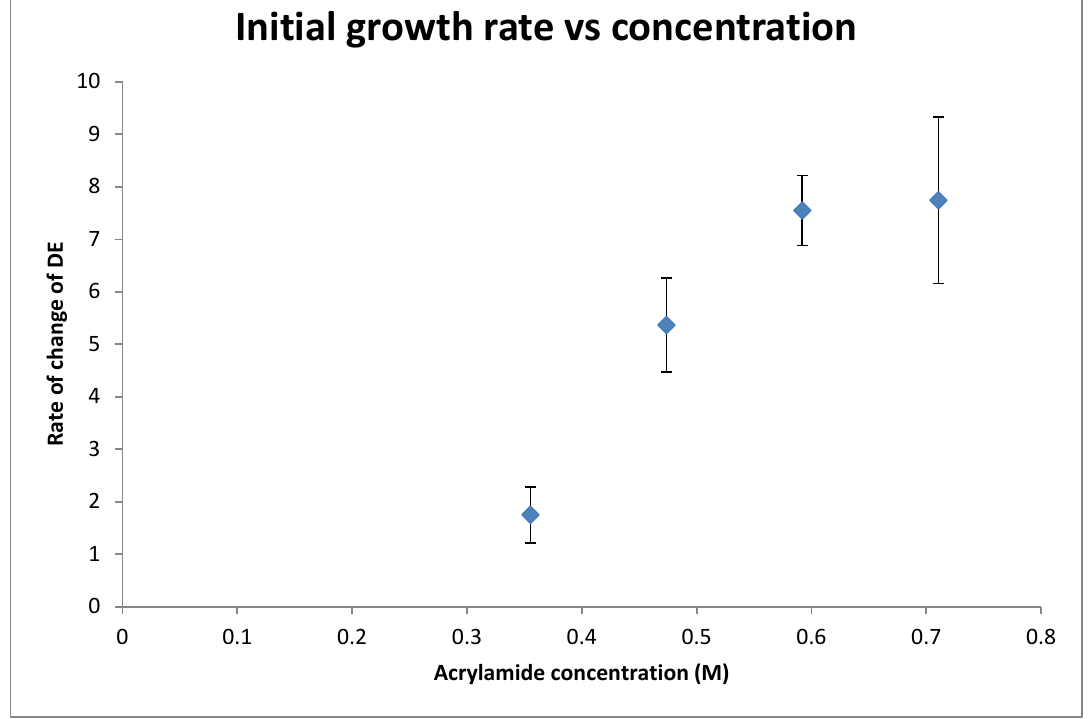
Figure 6. Initial growth rate vs. acrylamide concentration.